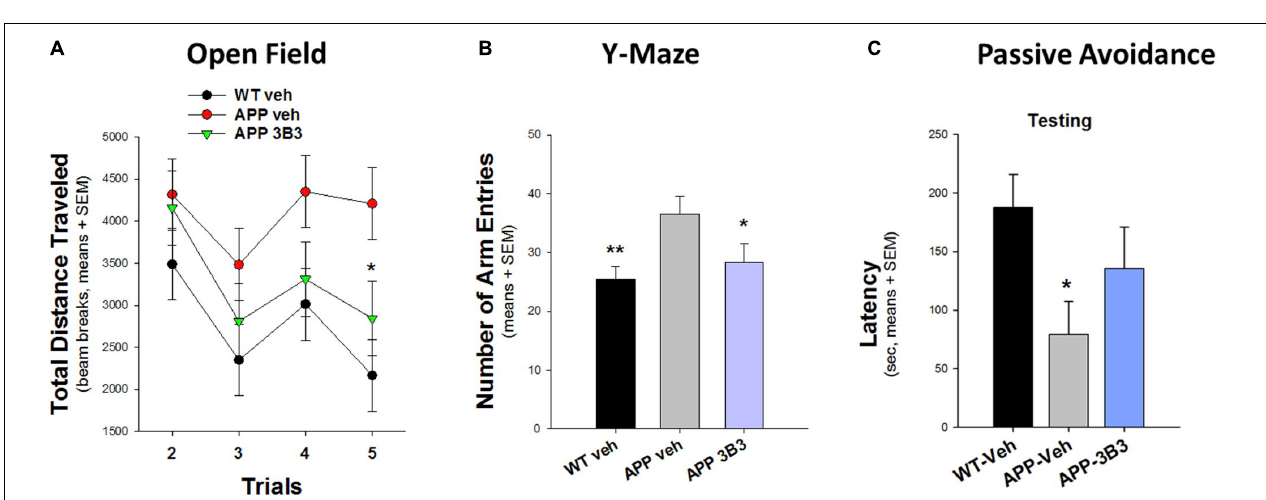
FIGURE 9 | ACU3B3 treatment in 9- to 10-month old APPSL mice ( n = 10/group) (Faizi et al., 2012) improves performance on the first day of water maze training ( A ; p = 0.057), decreases swim path length ( B ; p = 0.034), and reverses a swim speed abnormality ( C ; p < 0.02). **Signifies a P -values of < 0.01.